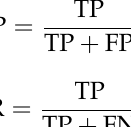
Figure 5. Loss values of YOLOv3 and the improved